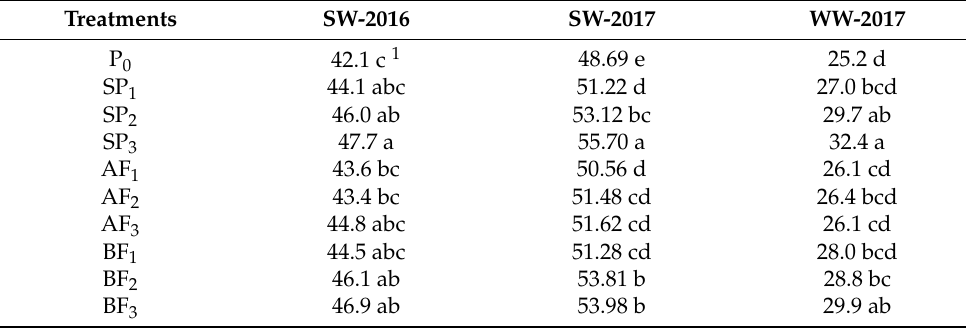
Table 9. Available P content in soil after wheat harvest, mg kg –1 . Treatments